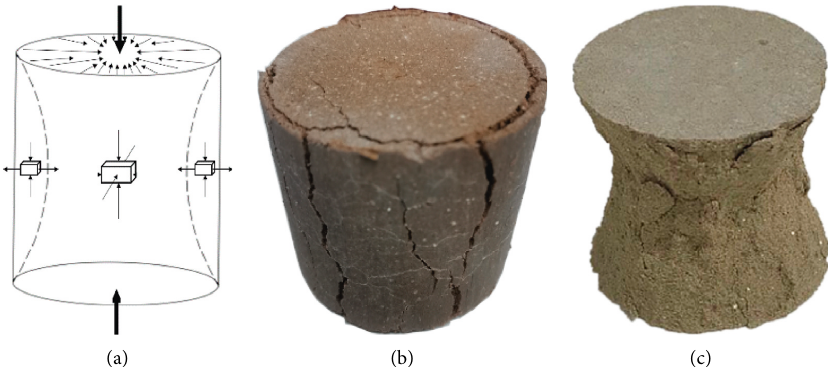
Figure 7: UNC compression failure mode and morphology. (a) Stress state. (b) Failure process. (c) Failure mode.